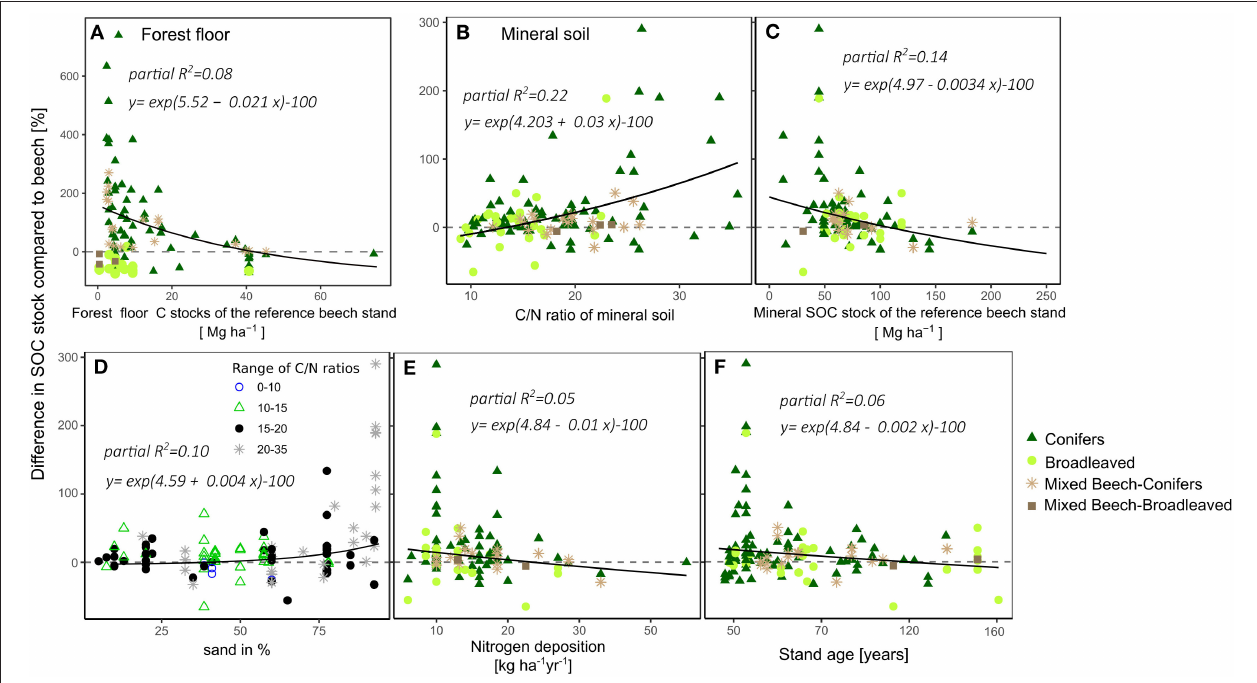
FIGURE 6 | Effects of statistically significant drivers on tree-species-induced differences in forest floor C stocks (A) and mineral SOC stocks (B–F) . For forest floor C stock differences, this was the forest floor organic C stock of the reference beech stand (A) . For the mineral soil differences, important drivers were (B) the C/N ratio of mineral soil, (C) the reference mineral SOC stock of the beech stand, (D) the soil sand content, (E) nitrogen deposition, and (F) the stand age. The solid lines represent the multivariate model predictions with average values assumed for all of the other variables in the model. The equations were obtained from the full multivariate model using the function: y = exp (4.85 − 3.4 * 10 − 3 a − 2.0 * 10 − 3 b + 0.03 c − 0.01 d − 2 * 10 − 3 e ) − 100, with the constants a- Mineral SOC stock of the reference beech stand [Mg ha − 1 ] = 78, b- sand in % = 60, c- C/N ratio of the mineral soil = 16.8, d- Nitrogen deposition [kg ha − 1 yr − 1 ] = 13.2, e- stand age (years) = 65. The effect of the sand percentage is partly confounded with the other effects. Therefore, the effect of sand content is illustrated using C/N